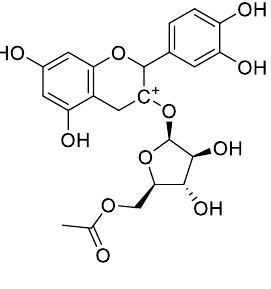
Figure 6. Chemical structure of cyanidin-3-O-( 6′’ -acetyl-arabinoside), one the major compounds of red maize.